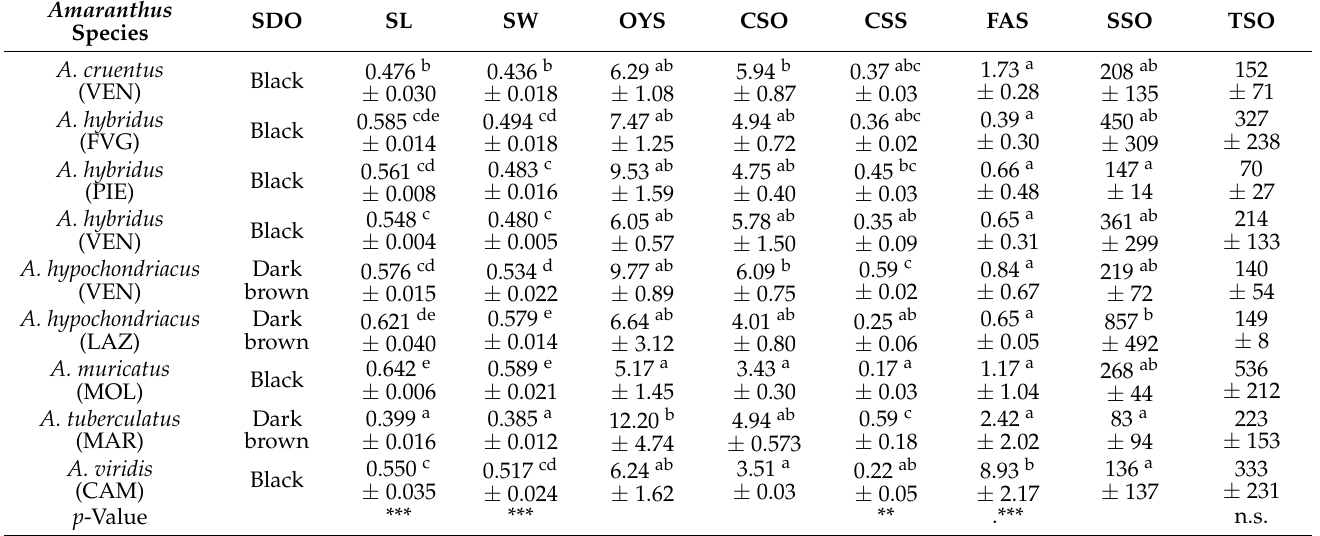
Table 2. Compositional characteristics of seeds of the six Amaranthus species collected from Italian wild habitats: SDO, seed color; SL, average seed length (mm); SW, average seed width (mm); OYS, average oil yield in seeds (%); CSO, average concentration squalene in oil (%); CSS, average concentration squalene in seeds (%); FAS, average free fatty acids in seed oil (%); SSO, average sterols in seed oil (ppm); TSO, average tocopherols in seed oil (ppm). Different letters (a–e) indicate significant differences according to Tukey’s HSD test ( p < 0.05). **, *** represent significant at p < 0.01, 0.001, respectively. n.s.: not